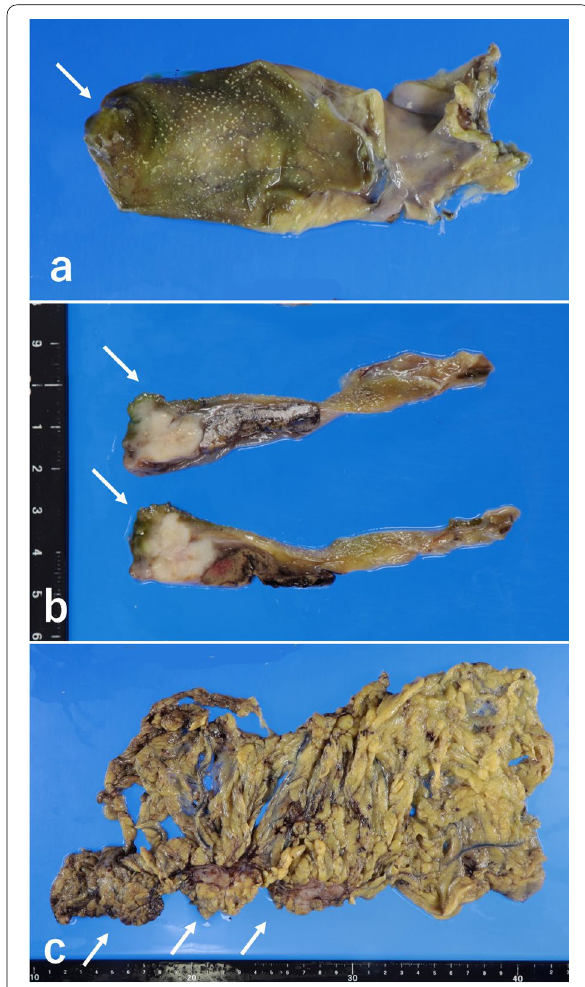
Fig. 3 a Gross findings for the primary carcinoma located at the fundus of the gallbladder (arrow). b Cut surface of the primary carcinoma (arrows). c Multiple metastatic tumors of the omentum